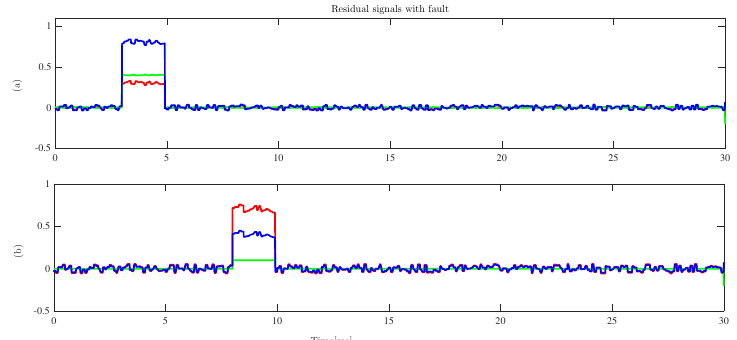
Figure 8. ( a ) Residual signals for Mode 1 ( b ) Residual signals for Mode